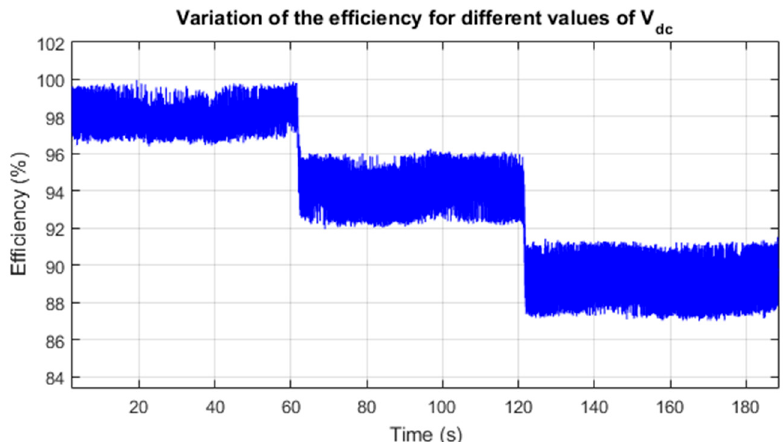
Figure 30. Power transfer efficiency variations.